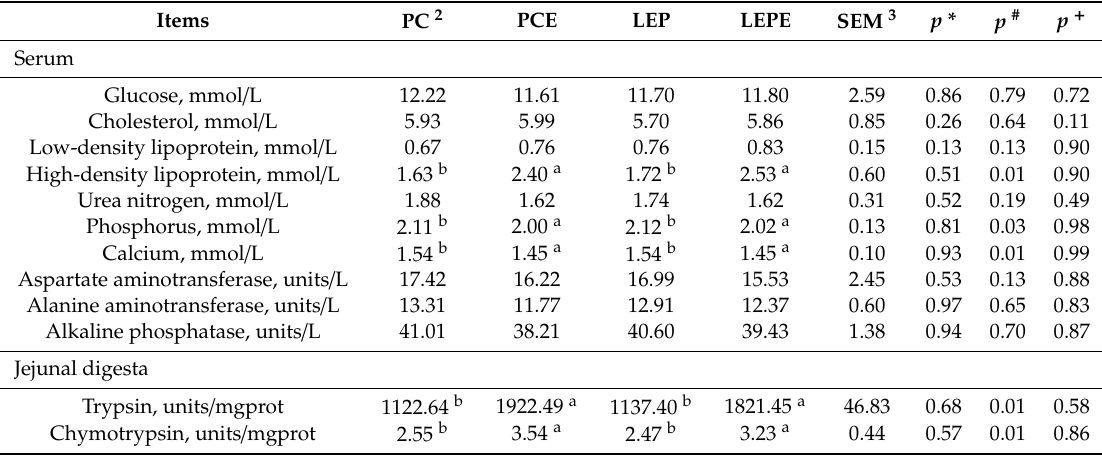
Table 6. E ff ects of protease and phytase in low energy and protein diet on serum physiochemical parameters and digestive enzyme activities in ducks 1